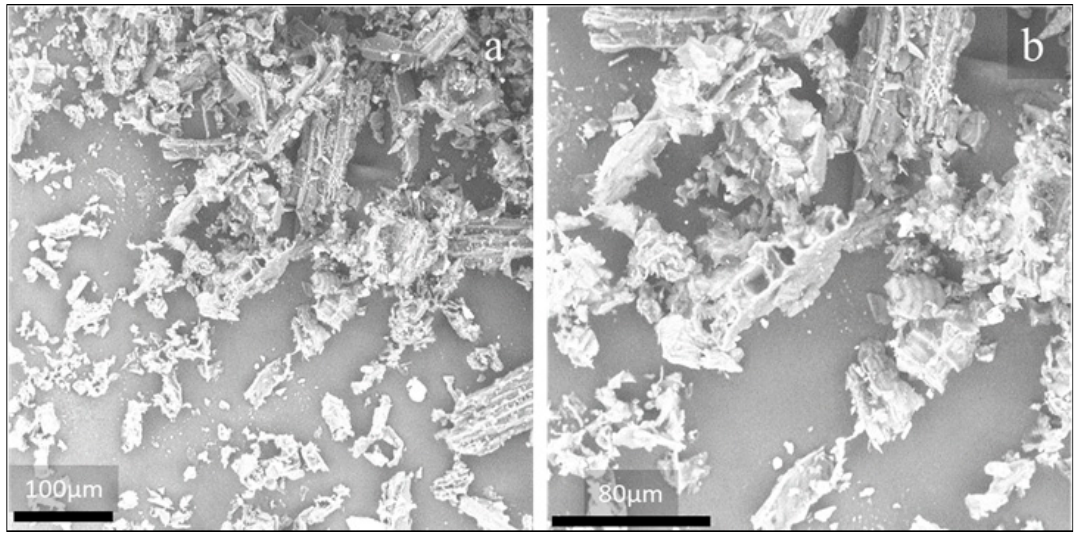
Figure 6. SEM micrographs of POL fibers before processing, at 500× ( a ) and 1000× ( b ) magnification.